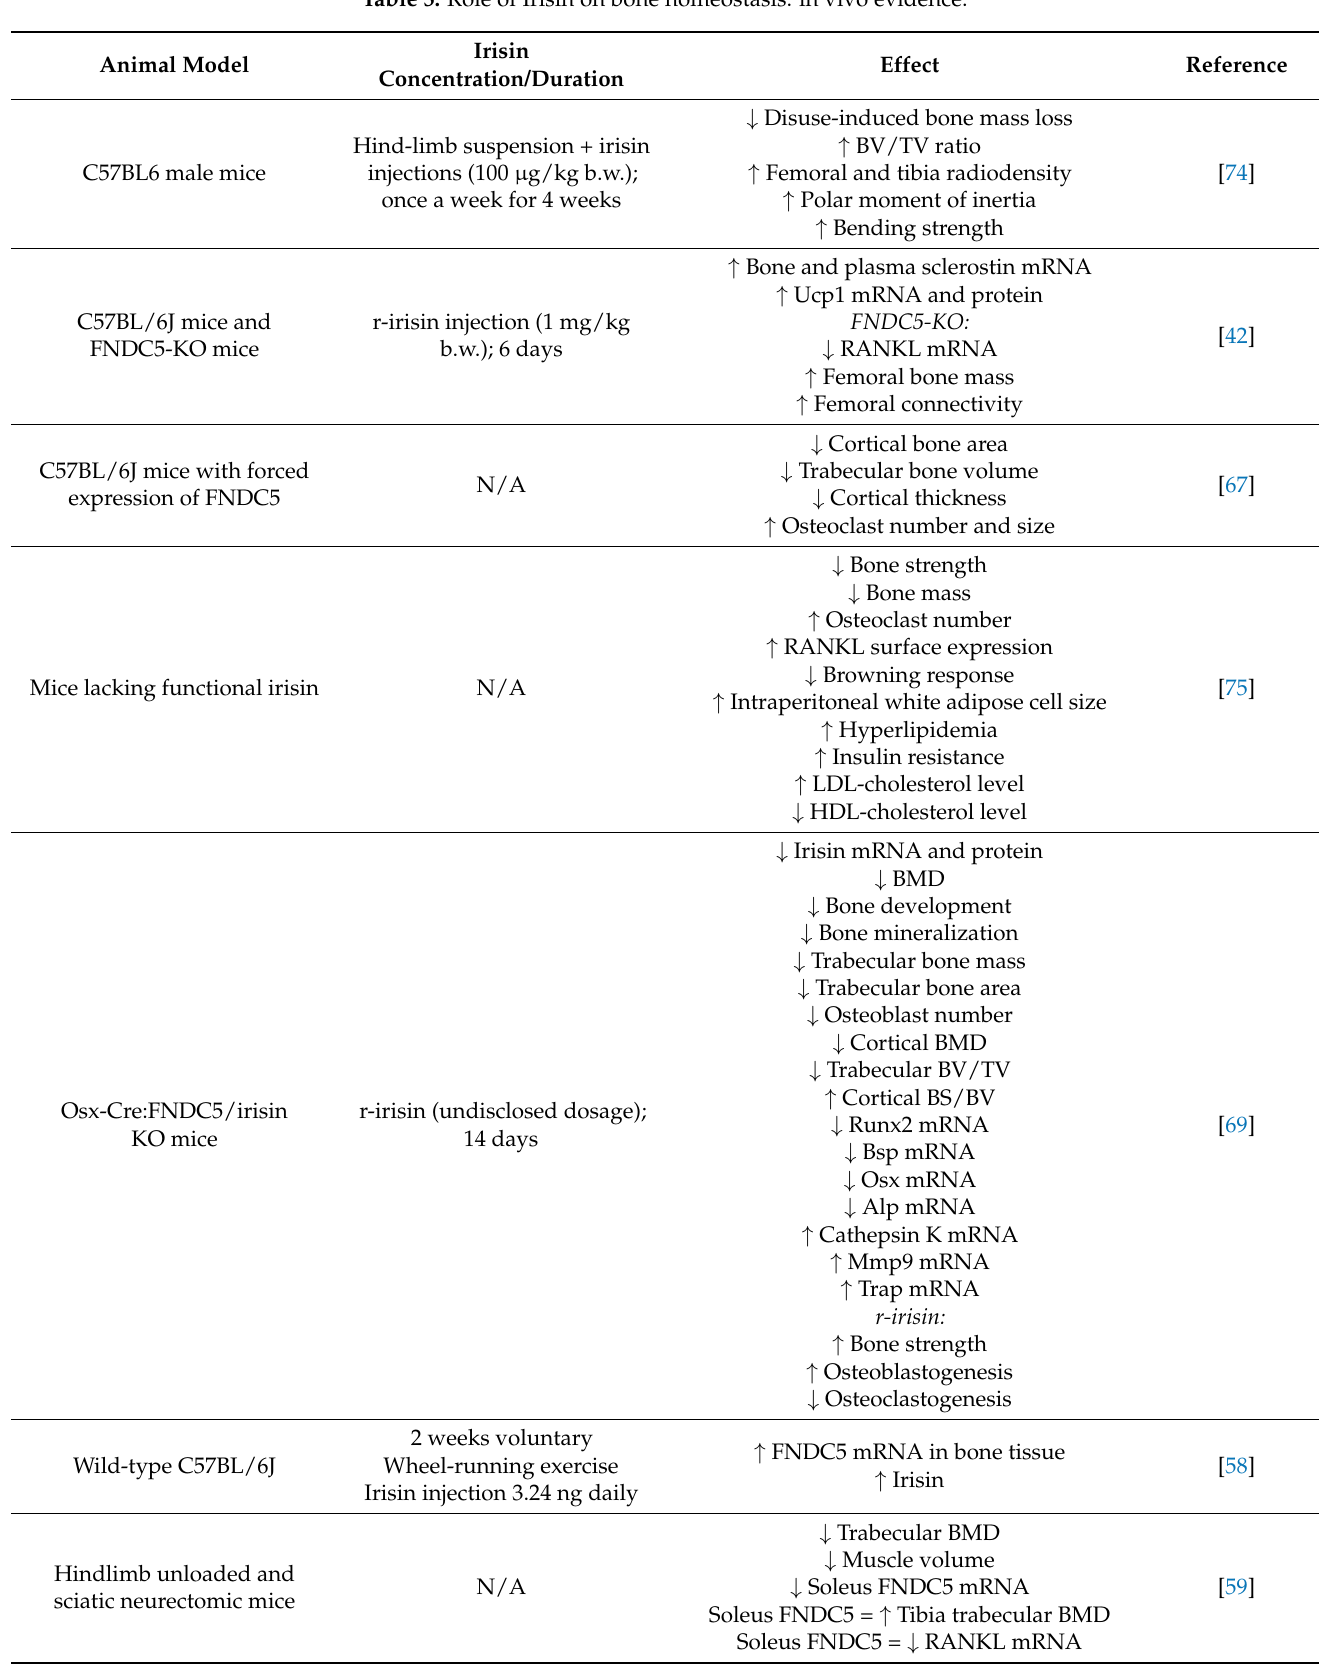
Table 5. Role of Irisin on bone homeostasis: in vivo